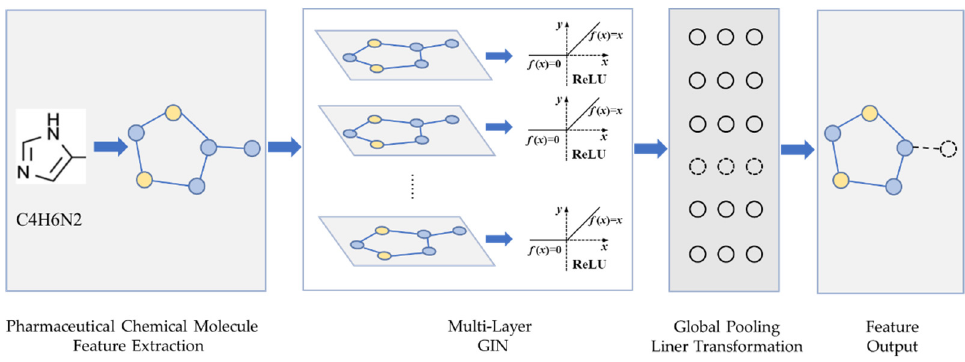
Figure 1. Feature extraction model for drugs.